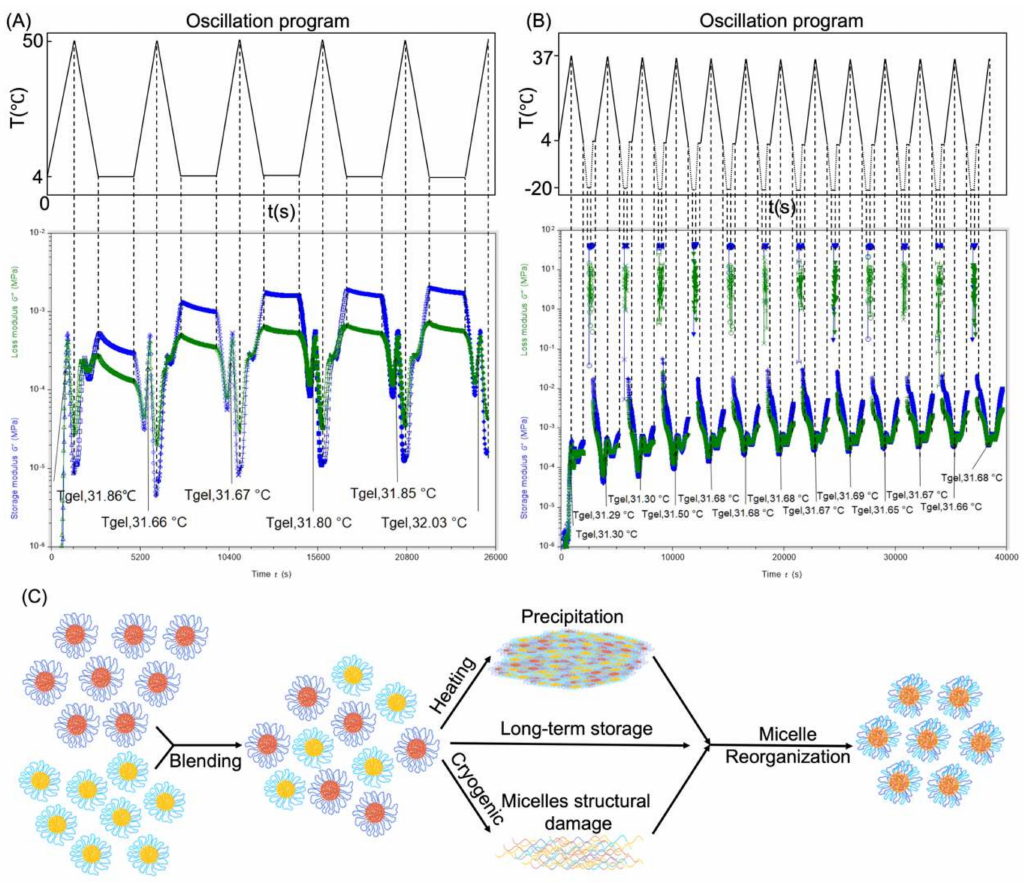
Figure 8. Thermo–reversibility of PLGA–PEG–PLGA hydrogel. ( A ) Heat recovery. ( B ) Freeze–thaw recovery. ( C ) Schematic diagram of micelle